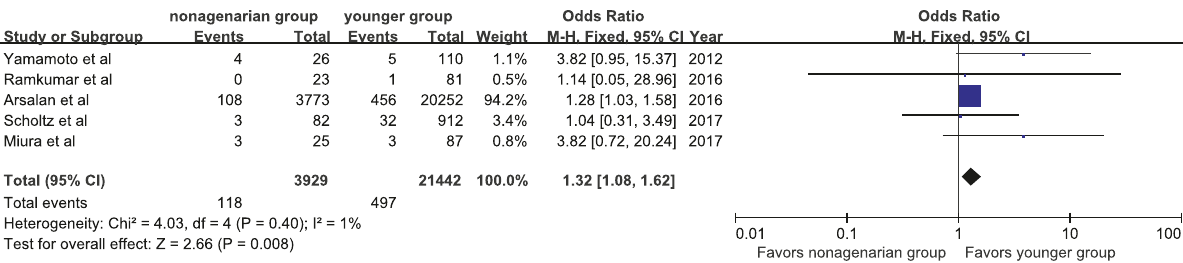
Figure 8: Forest plot of pooled analysis comparing the rates of stroke in nonagenarians versus younger patients.